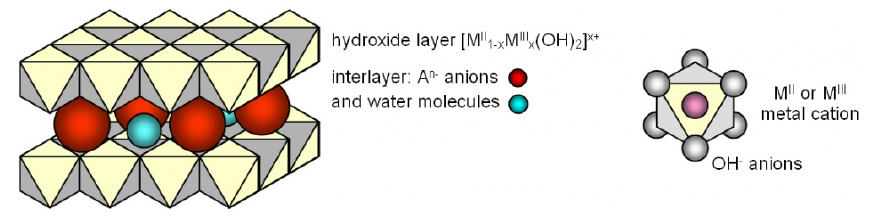
Figure 1. The structure of LDHs.